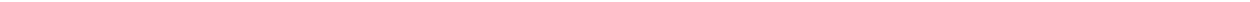
Fig. 3 Increased stabilization and activation of mutant NRF2. a Representative western blot of endogenous level of NRF2, KEAP1, G6PD, AKR1B10 and AKR1C1 in protein lysates of human primary fi broblast cell lines from two controls (NRF2 WT 1, WT 2) and patient 1 with NRF2 p.T80K variant. Full blots are shown in Supplementary Fig. 6. b Quantitative analysis of western blot images illustrating the endogenous level of NRF2, KEAP1, G6PD, AKR1B10 and AKR1C1 relative normalized to ACTB and NRF2 WT 1. c qRT – PCR analysis of NFE2L2, KEAP1 and target gene expression in primary fi broblast cell lines from two controls (NRF2 WT 1, WT 2) and patient 1 with NRF2 p.T80K variant. AKR1B10 and AKR1C1 are visualized on a separated X axis due to the high range.